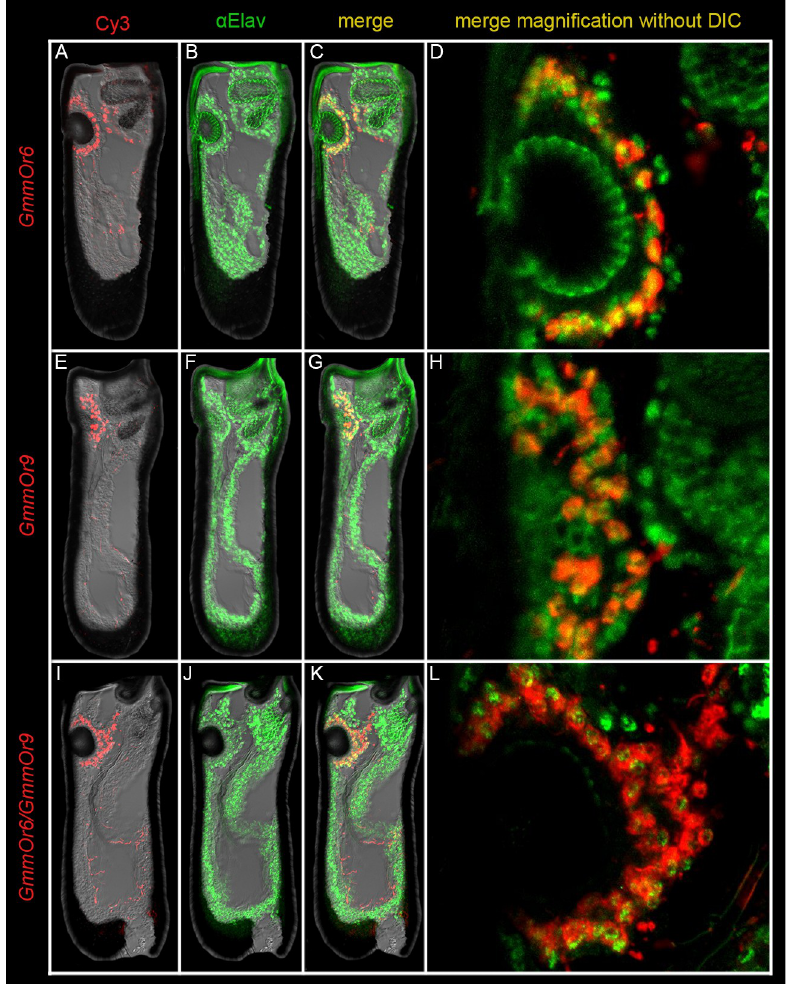
Fig 6. GmmOr6 and GmmOr9 are transcribed in adjacent ORNs that encapsulate the sensory pit. (A-D) In situ hybridization to GmmOr6 (red) combined with anti-Elav immunostaining (green). (A) GmmOr6 , (B) anti-Elav, and (C) merged image of the whole antenna. (D) Magnified merged image of the sensory pit without DIC. The circular structure in the center of the image that is uniformly green is autofluorescent cuticle of the pit. Likewise, the green fluorescence in the upper right corner is cuticular autofluorescence from the sacculus. (E-H) In situ hybridization to GmmOr9 (red) combined with anti-Elav immunostaining (green). (E) GmmOr9 , (F) anti-Elav, and (G) merged image of the whole antenna. (H) Magnified merged image of the sensory pit without DIC. (I-L) Double in situ hybridization to GmmOr6 and GmmOr9 (both red) combined with anti-Elav immunostaining (green). (I) GmmOr6 and GmmOr9 , (J) anti-Elav, and (K) merged image of the whole antenna. (L) Magnified merged image of the sensory pit without DIC.